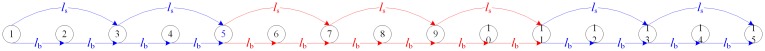
Distribution of different areas along a corridor.